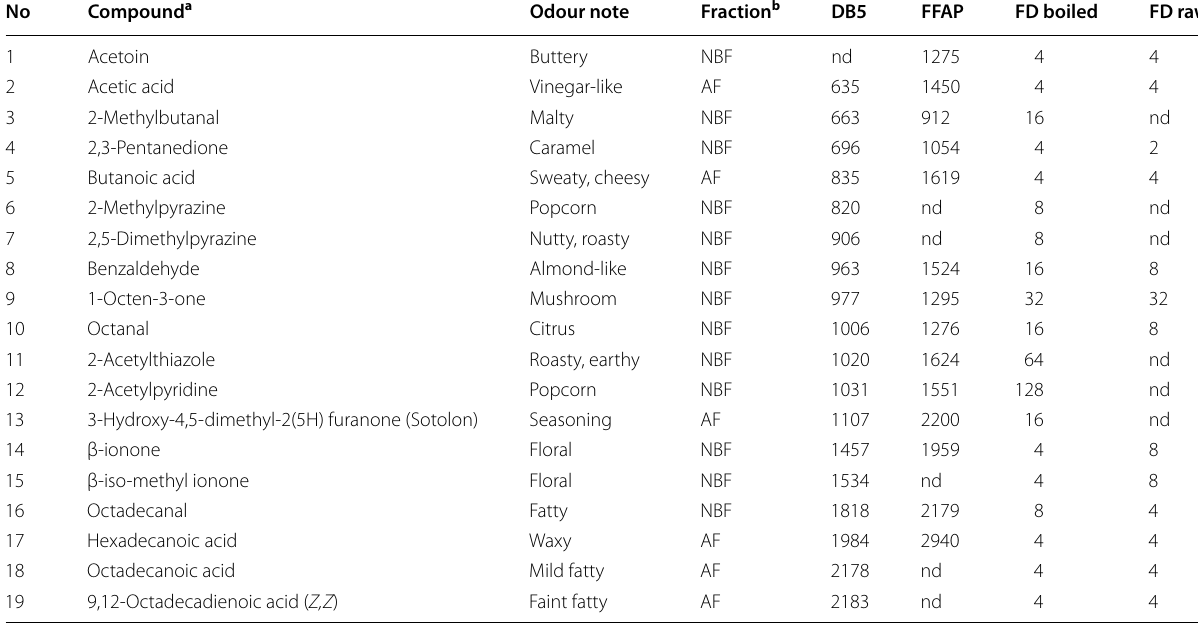
4) in raw and boiled giant snail meat ( A. fulica ) ≥